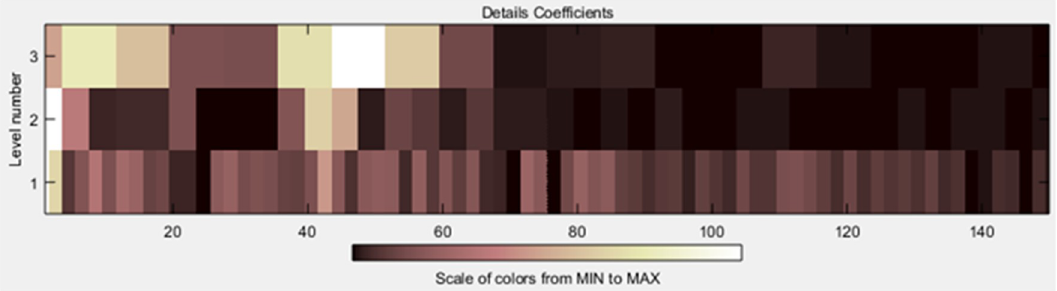
Figure 17. Detail coefficients related to the double upward movement.